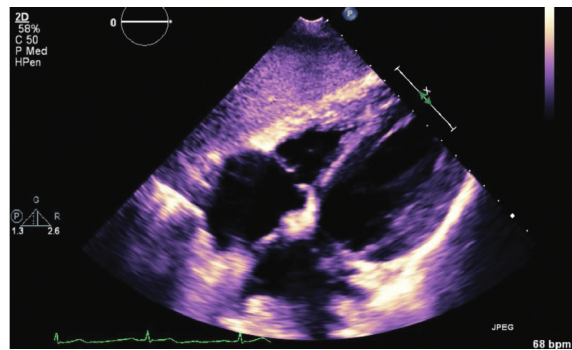
Figure 4: Transthoracic echocardiogram (TTE) after antifungal treatment with resolution of the large fungal